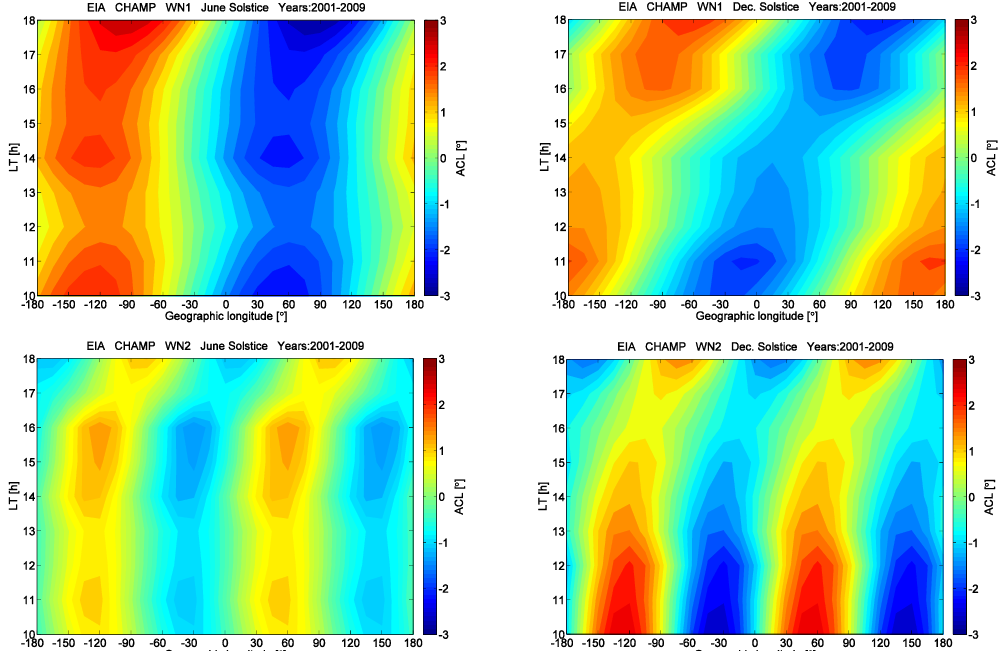
Fig. 7. Filtered data of EIA inter-hemispheric asymmetry from the months around June (left) and December (right), zonal wavenumber 1 (top) and wavenumber 2 (bottom).